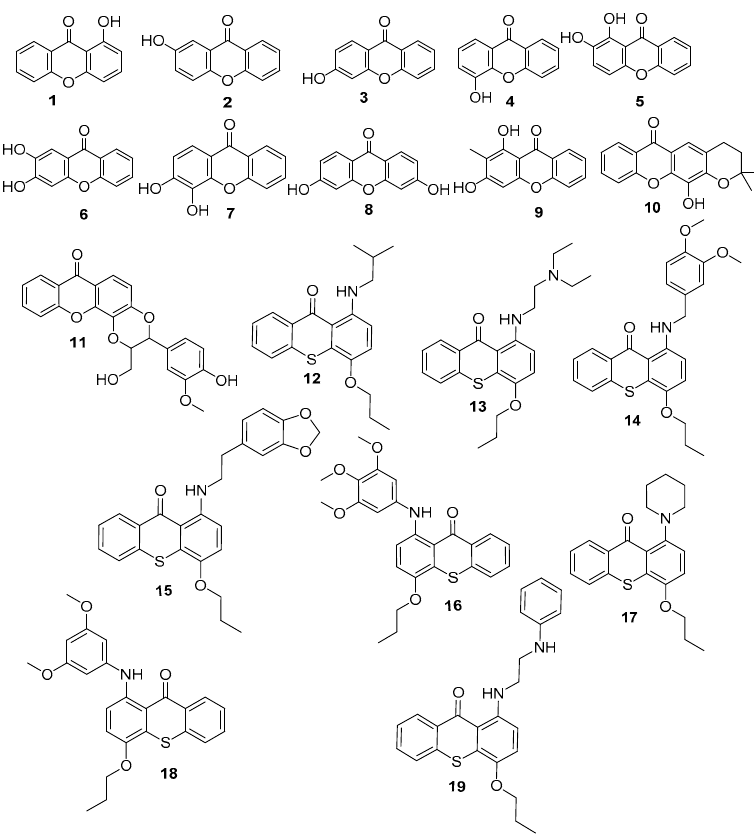
Figure 1. Library of xanthones investigated for antifouling activity.